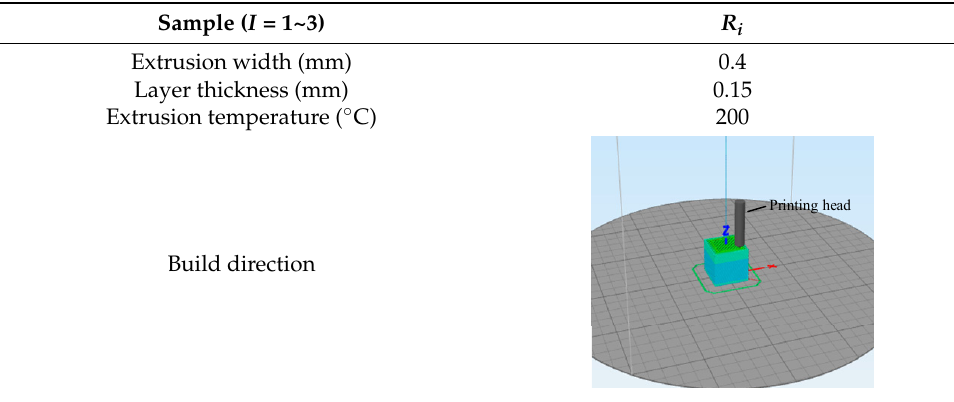
Figure 8. The ME equipment and testing samples: ( a ) ME device; ( b ) three-dimensional drawing of the samples.